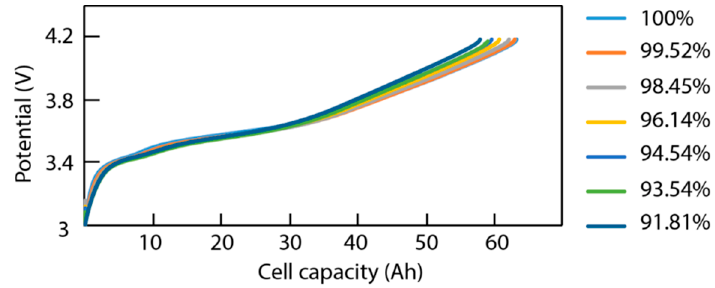
Figure 7. Evolution of the discharge curve of a cell with aging during a discharge at C/2 at 23 °C. Curves are shown according to their State of Health (SOH).